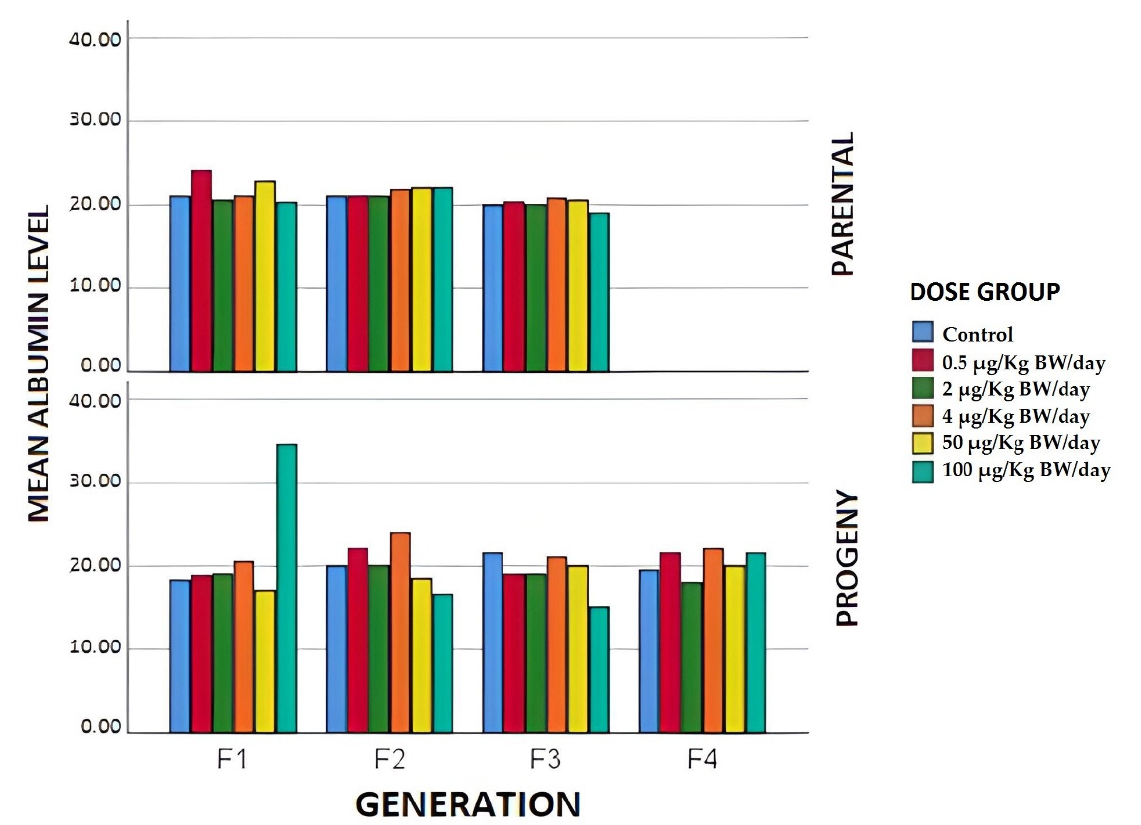
Figure 5. Mean albumin values expressed in g/L in the different generations of breeders and offspring in terms of the exposure group.